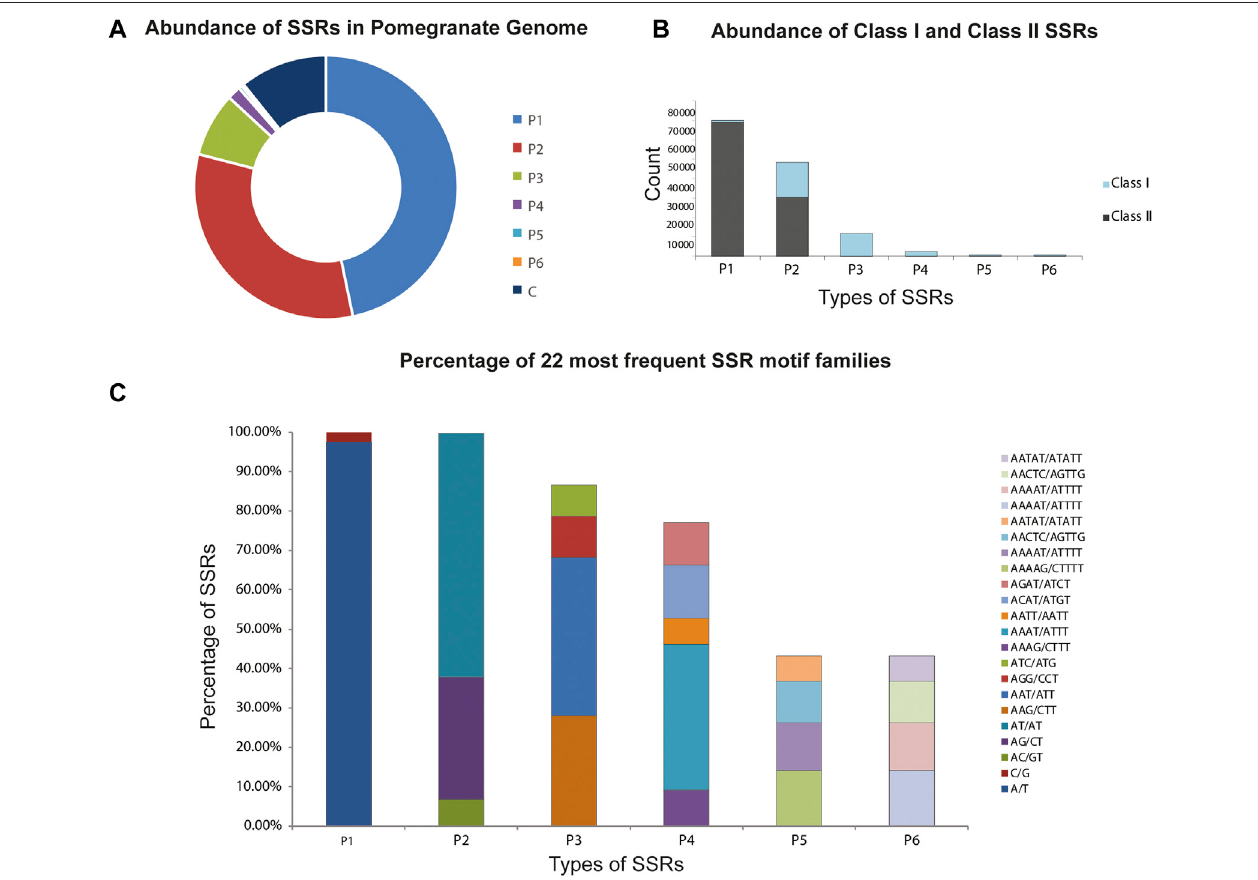
FIGURE 2 | Classi fi cation and distribution of microsatellites alias SSRs identi fi ed in the P. granatum genome. (A) Proportions of microsatellites with different motif types. P1: mono-nucleotide repeats; P2: di-nucleotide repeats; P3: tri-nucleotide repeats, P4: tetra-nucleotide repeats; P5: penta-nucleotide repeats; p6: hexa- nucleotide repeats; C: complex: no. of SSRs involved in compound formation. (B) Percentage of hypervariable class I and variable class II microsatellites in the P. granatum genome. (C) Frequency of distribution of the most frequently occurring SSR motif families.